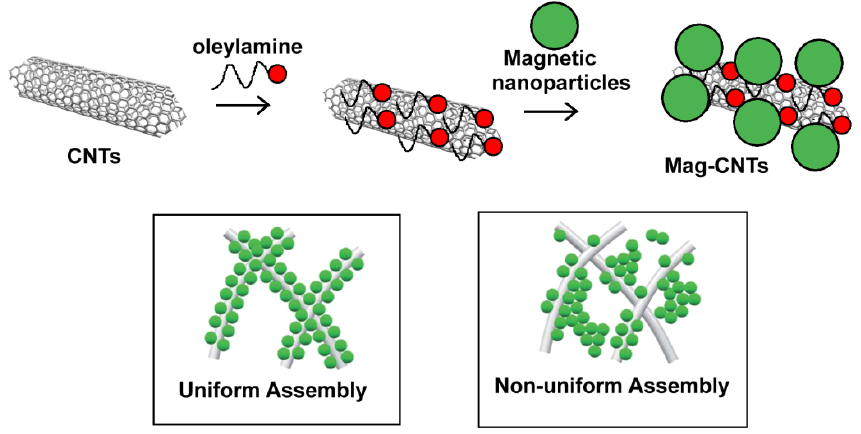
Figure 12. Schematic procedure to obtain CNTs coated with magnetic nanoparticles (Mag-CNTs). Two different assemblies of NPs onto CNTs can be obtained: uniform ( left ) and non-uniform ( right